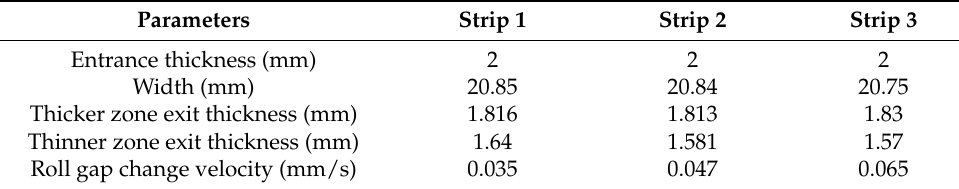
Table 1. Experimental parameters of dynamic